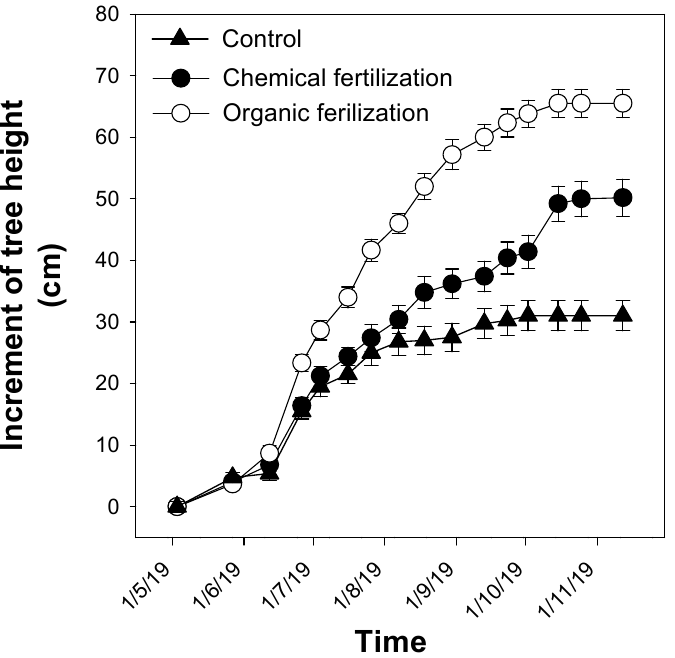
Figure 2. Increase in height of chemically or organically fertilized potted trees and of unfertilized ones (control) during the vegetative season of 2019. Bars represent standard errors ( n = 6).